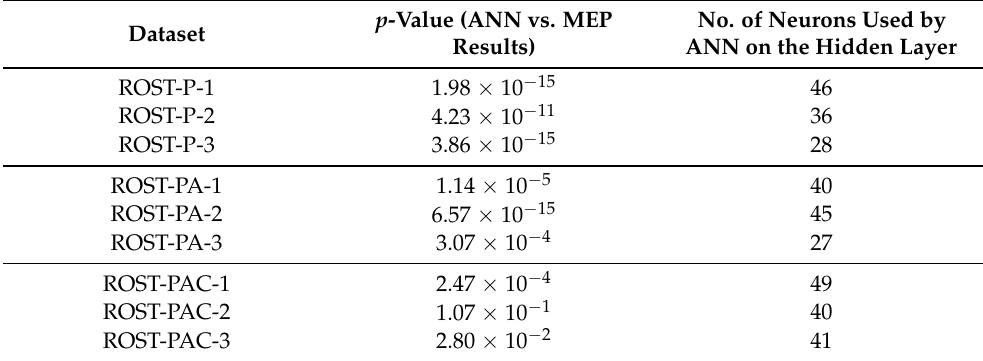
Table 18. p -values obtained when comparing MEP and ANN results over 30 runs. No. of neurons used by ANN on the hidden layer represents the best-performing ANN structure on the specific ROST-*-*.